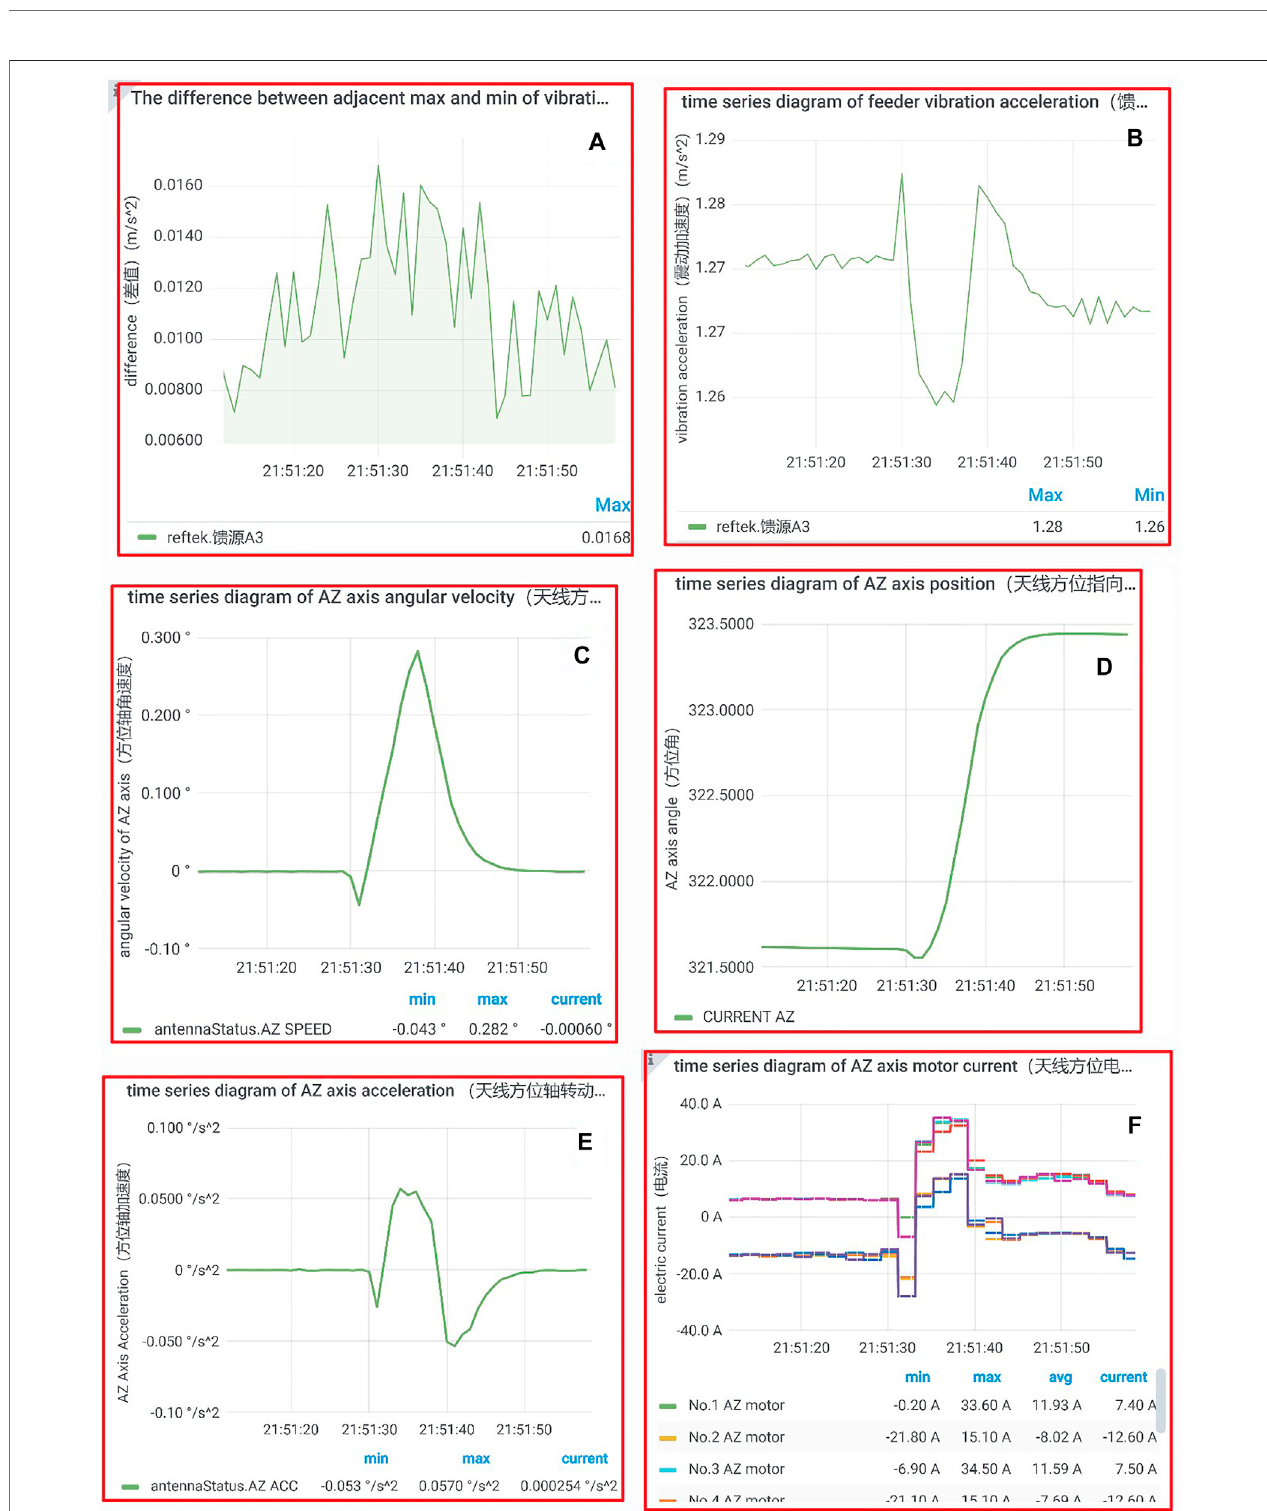
FIGURE 3 | This is a visualization page in TAEWS. (A) is the difference between adjacent max and min of vibration acceleration, (B) is the time-series diagram of feedervibration acceleration, (C) isthe time-series diagram ofAZaxis angular velocity, (D) isthe time-series diagram ofAZ axis position, (E) isthetime-seriesdiagramof AZ axis acceleration, (F) is the time-series diagram of AZ axis motor current.